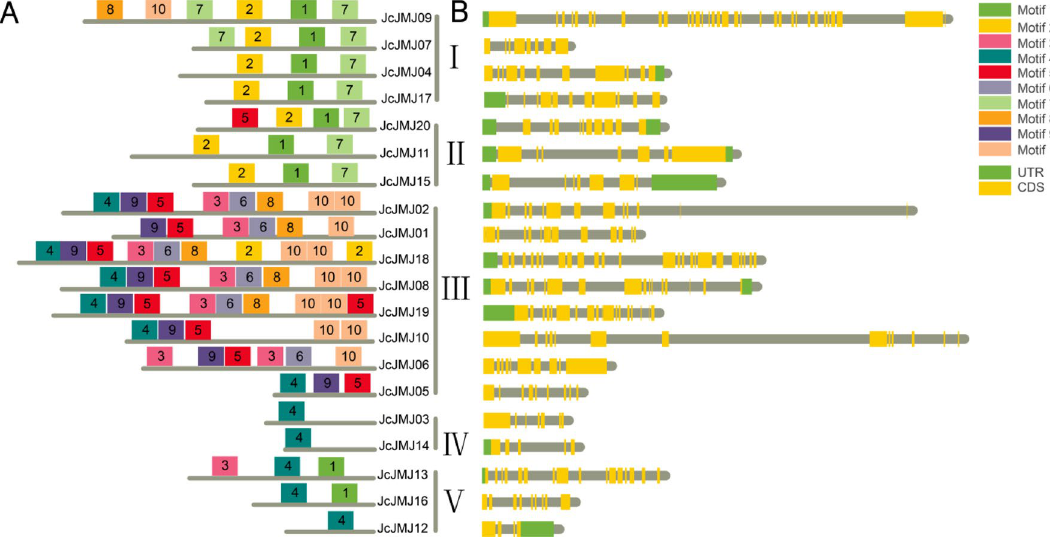
Figure 3. Motifs and gene structures of JcJMJ genes in J. curcas . ( A ) Different kinds of motifs are marked by boxes with different colors. ( B ) Gene structure of 20 JcJMJ genes. UTRs and CDSs are marked by green and yellow boxes respectively. Grey rounded rectangles represent introns.